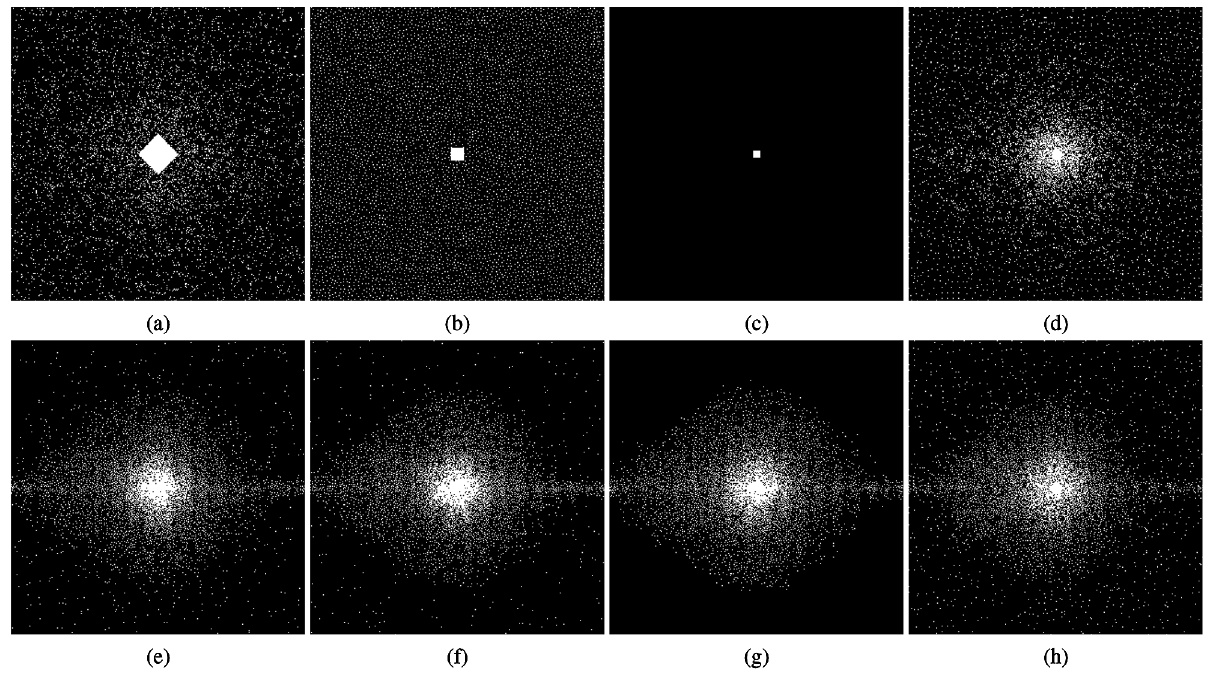
Figure 4. Efficient solutions produced for P-LORAKS with AF = 16 and initial SPs ( a ) variable density (VD), ( b ) Poisson disk (PD), ( c ) an SP that is empty except for a small central area (CA), and ( d ) adaptive SP. The corresponding efficient solutions are the SPs in ( e ) for VD ( NRMSE = 0.196 ), in ( f ) for PD ( NRMSE = 0.195 ), in (g) for CA ( NRMSE = 0.194 ), and in ( h ) for adaptive SP ( NRMSE = 0.199